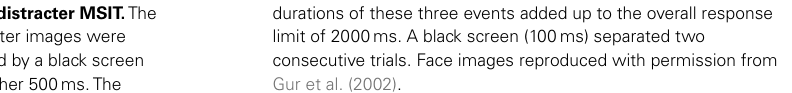
durations of these three events added up to the overall response limit of 2000ms. A black screen (100ms) separated two consecutive trials. Face images reproduced with permission from Gur et al.